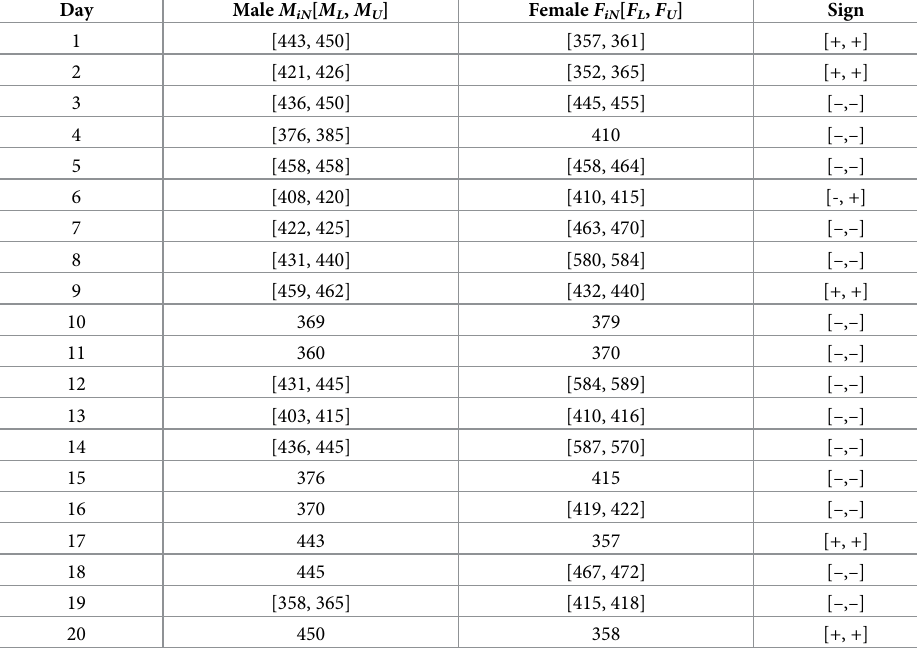
Table 2. Necessary calculation for the neutrosophic sign